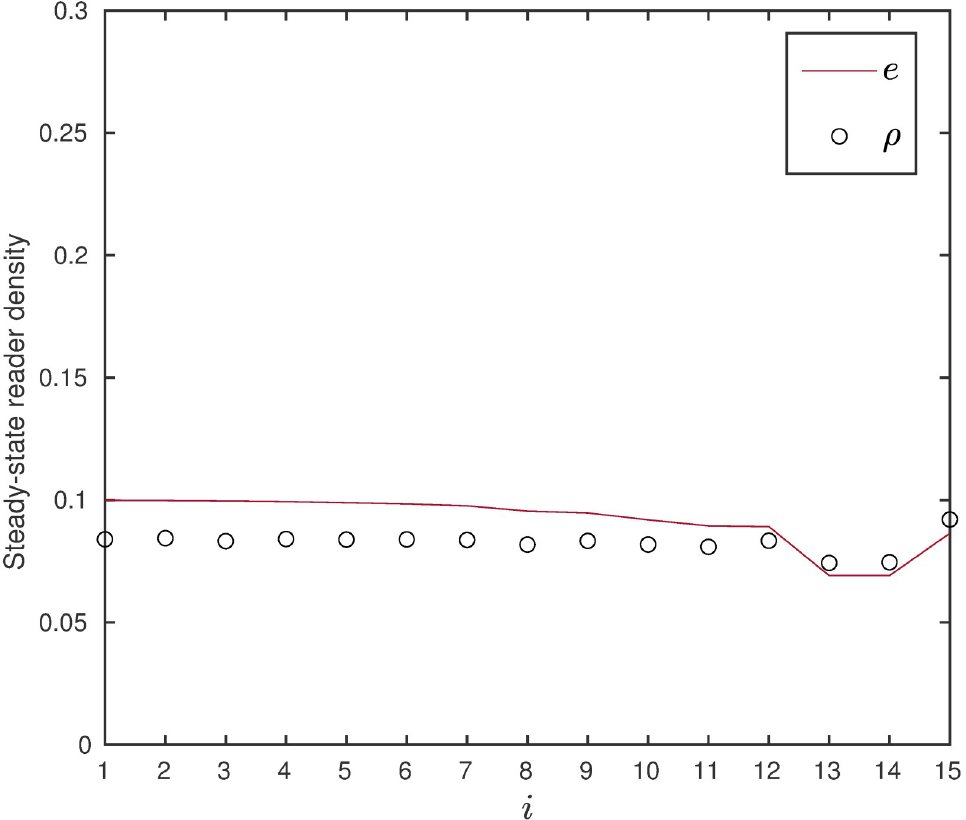
Fig 18. Steady-state reader density as a function of site number i given in Example